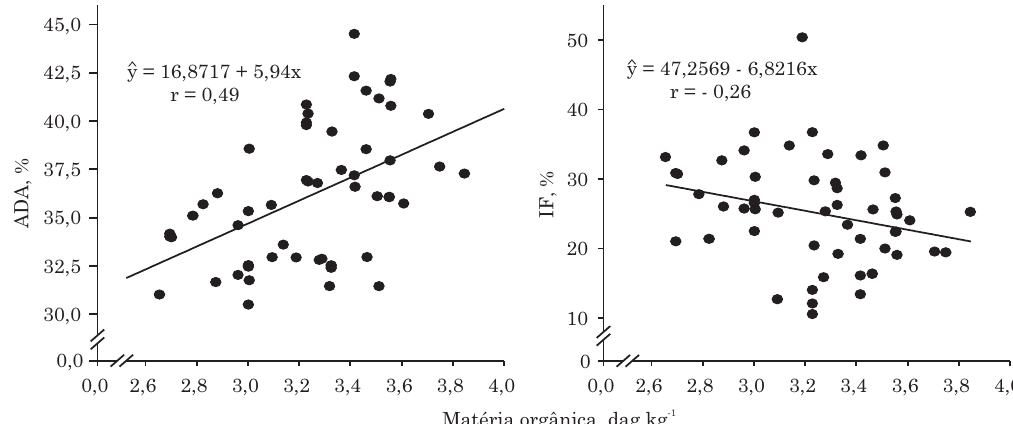
Figura 1. Correlação entre argila dispersa em água (ADA) e índice de floculação (IF) com a matéria orgânica do Latossolo Vermelho-Amarelo, submetido a métodos de controle de plantas invasoras em